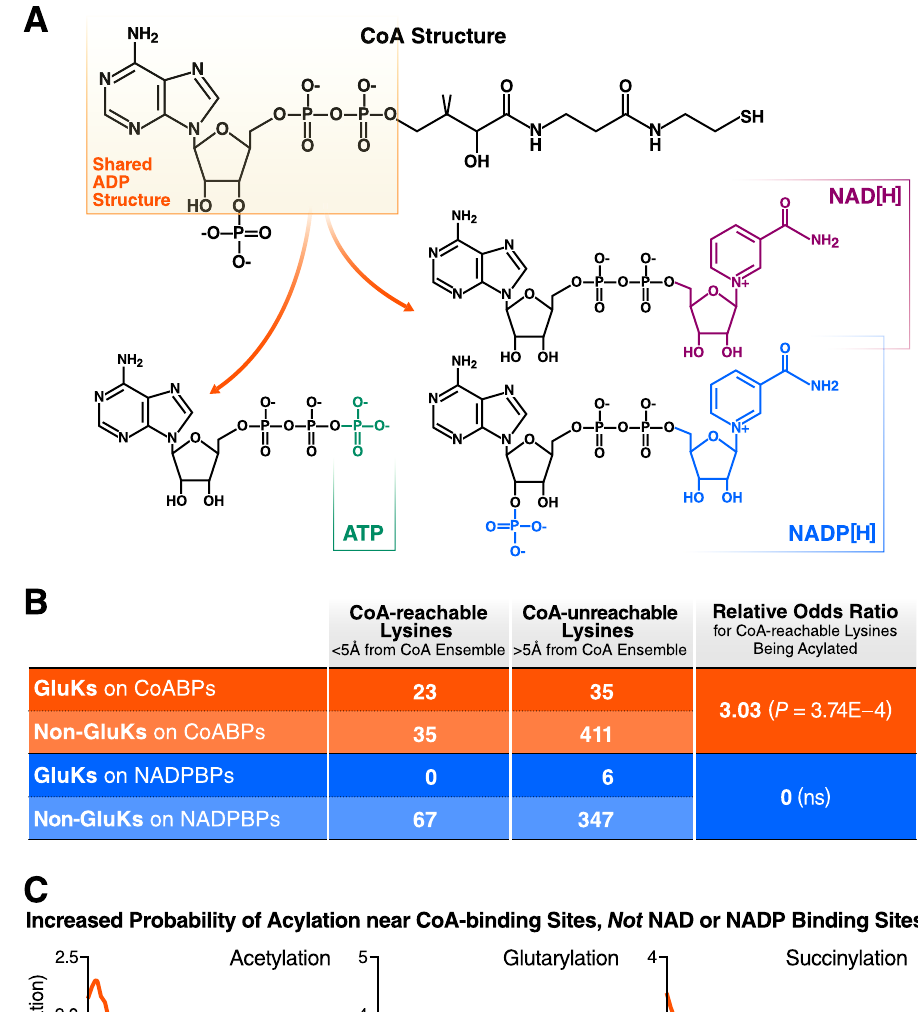
Figure 4. Proximal hyperacylation is specific to CoA-binding sites. ( a ) Illustration of the structural similarities between CoA and ADP, ATP, NAD, and NADP. CoA shares a core ADP moiety with ATP, NAD, and NADP, but its added 3 ′ phosphoryl group may prevent it from fitting in binding sites of those species. ( b ) Table comparing the relative odds ratios of CoA-reachable lysines being glutarylated by CoA-binding protein and NAD[P]- binding proteins. ( c ) Relative probability of lysine acylation as a function of a lysine’s distance from the CoA ensemble built into [acyl-]CoA, NAD, and NADP binding sites, showing a lack of acylation enrichment near NAD and NADP binding